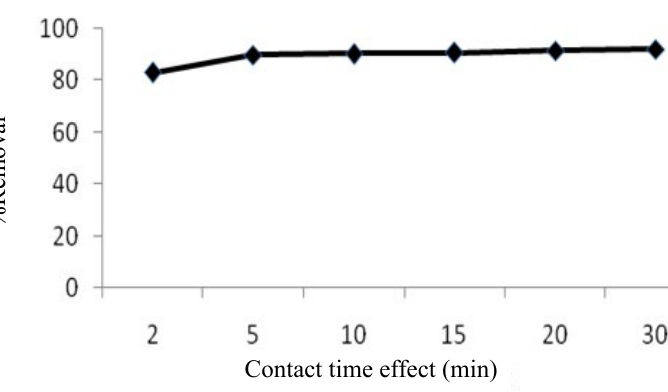
Fig. 1: Effect of contact time on adsorption